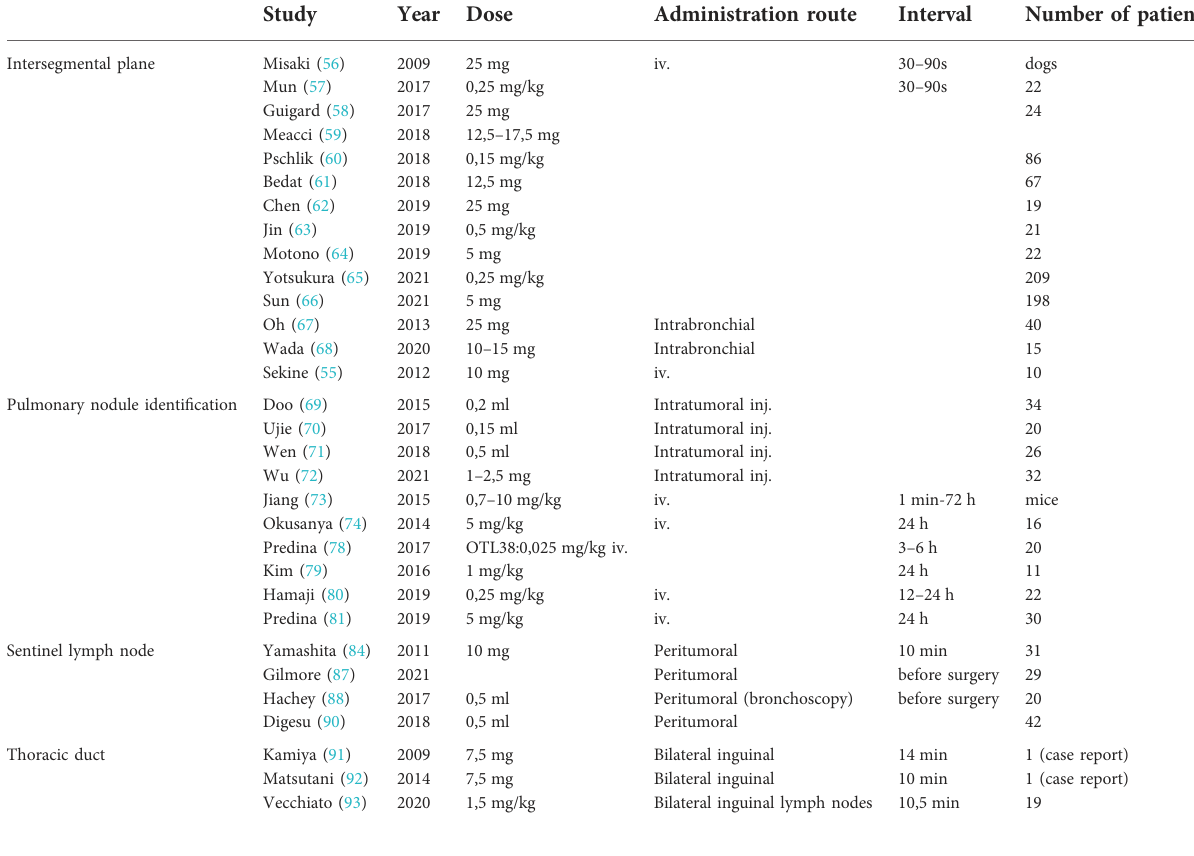
TABLE 1 Different applications of near-infrared fl uorescence-guidance in thoracic surgery.